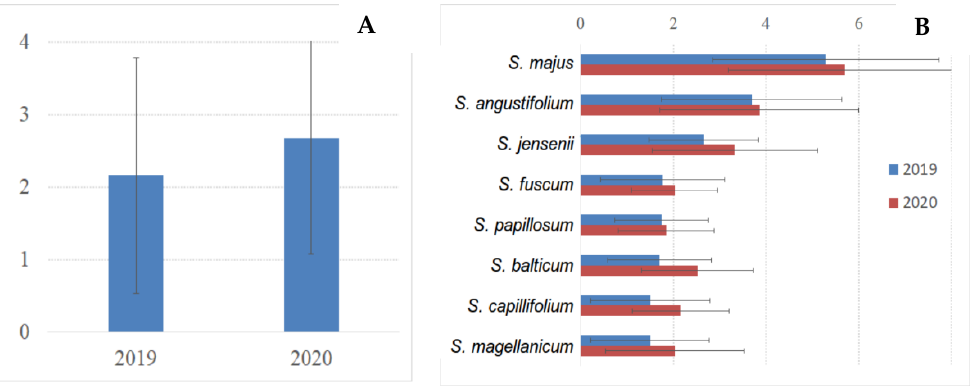
Figure 8. Mean annual growth increment of Sphagnum for all species cumulatively ( A ) and individually ( B ) in two successive years of measurements (2019, 2020).